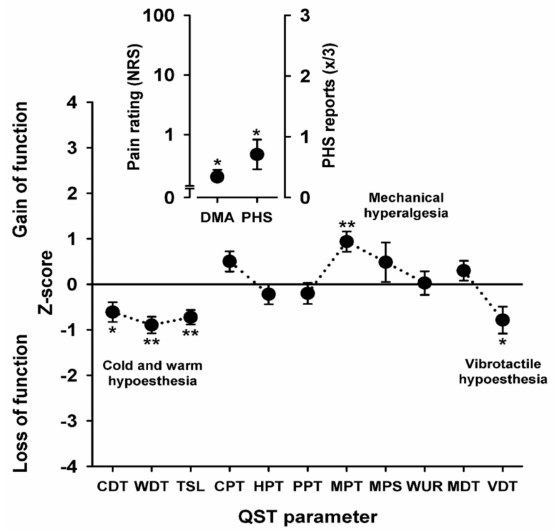
Figure 2. Sensory profiles. Z-score sensory profile of all patients ( n = 24) compared with a sex-, age -, and location-matched control group ( n = 24). The profile shows loss of function for non- painful thermal stimuli (CDT, WDT, TSL) corresponding to small fiber dysfunction. The presence of mechanical hyperalgesia to pinprick (MPT) and dynamic mechanic allodynia (DMA) points towards possible secondary central sensitization of the nociceptive system. The vibrotactile hypoesthesia (VDT) is consistent with large fiber involvement in this patient group. The increased number of paradoxical heat sensations (PHS) might be attributed to peripherally or centrally disturbed thermal discrimination. Stars denote the level of significance with * p < 0.05; ** p < 0.01 (one-way ANOVA).